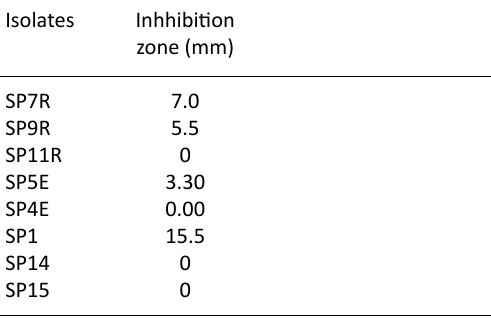
table 1. Inhibition zone produced by antagonistic bacteria against F. oxysporum Isolates